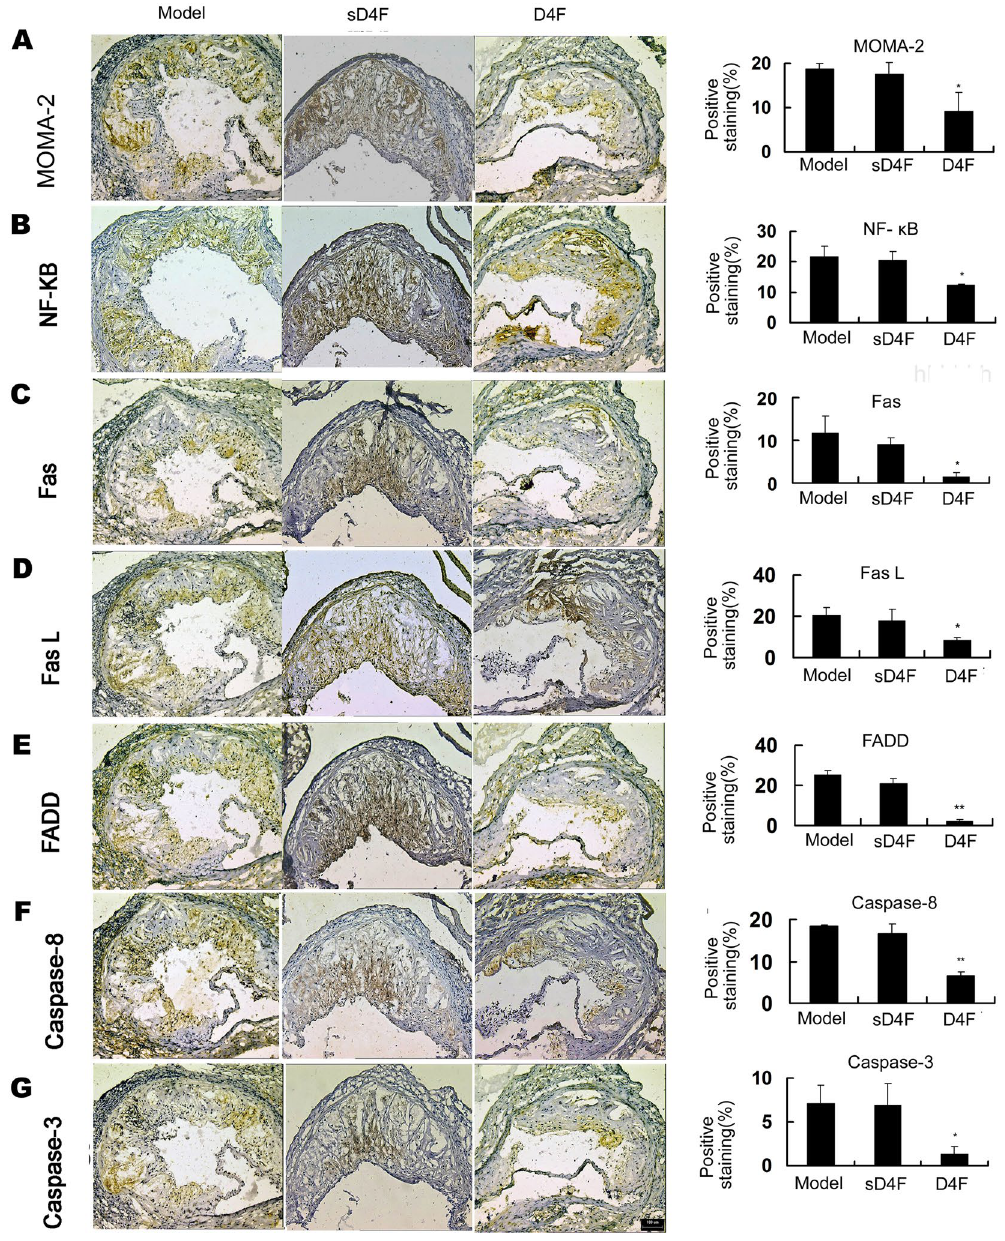
Figure 6. D4F inhibits the expression of P65 and Fas/FasL pathway-related molecules in atherosclerotic lesions of apoE − / − mice. Male apoE − / − mice were treated as described in Fig. 5. Immunohistochemical staining with specific antibodies against MOMA-2 ( A ), P65 ( B ), Fas ( C ), FasL ( D ), FADD ( E ), caspase-8 ( F ) and caspase-3 ( G ). Scale bar = 100 μ m. Blue indicates nuclei and brown indicates target protein. Densitometric quantification of MOMA-2, P65, Fas, FasL, FADD, cleaved-caspase-8 and cleaved-caspase-3 per field of view was calculated. Data are presented as the mean ± SD of eight independent experiments. * P < 0.05 and ** P < 0.01 versus model